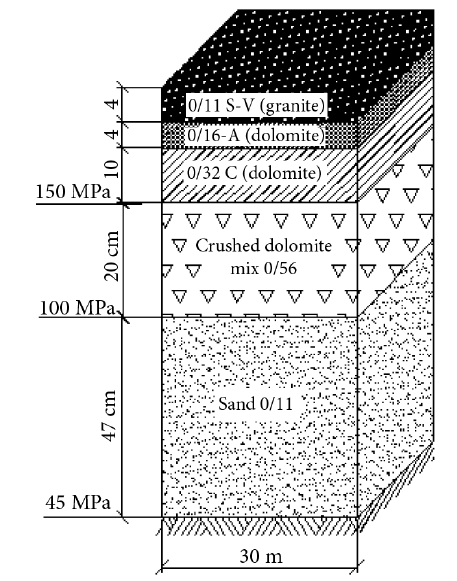
(Čygas et al. 2008)